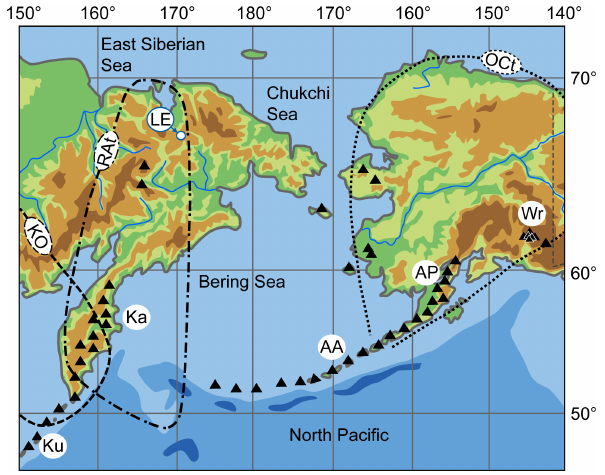
Figure 1. Location of Lake El’gygytgyn (LE) in relation to vol- canic areas in the Kuriles (Ku), Kamchatka (Ka), Aleutian Arc (AA) and Alaska Peninsula (AP). Reconstructed distribution patterns of Old Crow tephra (OCt; ∼ 124ka; Preece et al., 2011b), Rauchua tephra (RAt; ∼ 177ka; Ponomareva et al., 2013b) and KO tephra (KO; ∼ 7ka; Derkachev et al., 2004) illustrate the potential for widespread tephra distribution in this region. The Wrangell volcanic field (Wr) and other smaller cinder cones and maars, indicated by additional triangular markers, are too far afield and/or do not pro- duce the type of tephra deposits that are found in Lake El’gygytgyn. During glacial times, the Bering shelf between Russia and Alaska was exposed, and only mountainous areas in this region experienced limited glaciation, creating the glacial refugium known as Beringia. As a result, Beringia contains terrestrial paleoenvironmental records that rival marine deposits in their richness and